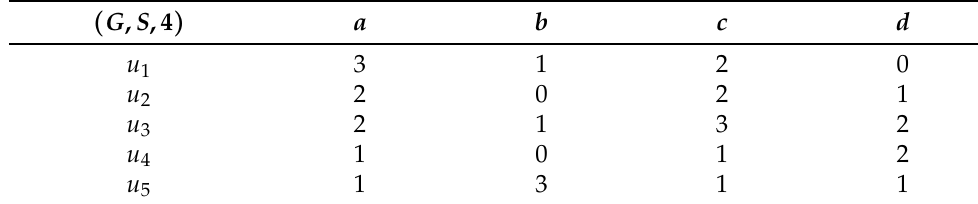
Table 11. The 4-Soft Set of ( G , S ,4 ) .